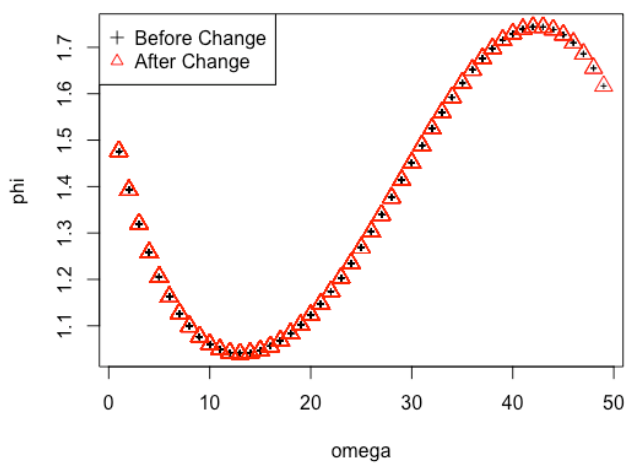
Figure 6. Plots of φ ∗ s in the AHPC method against ω jk s under the original sequential order and jk switched order.